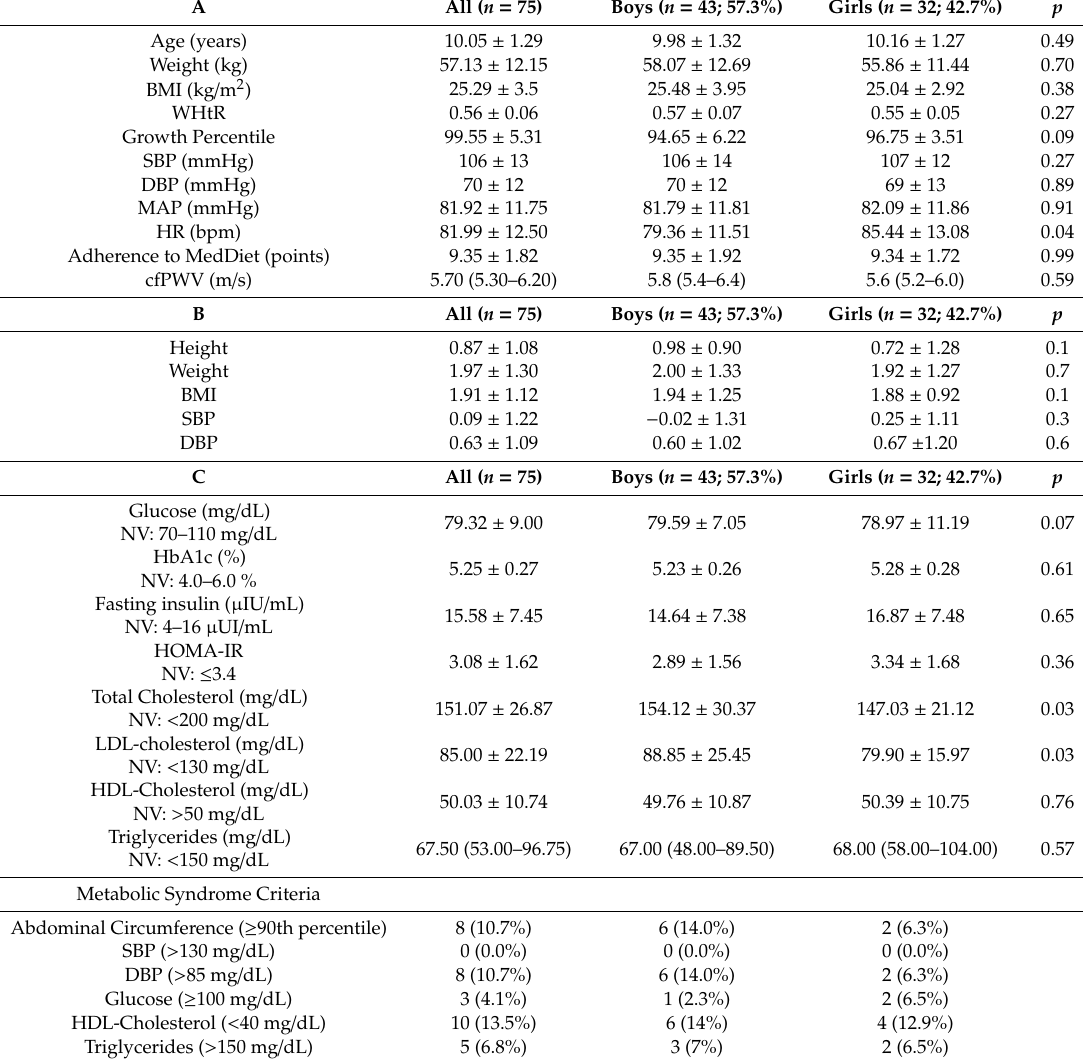
Table 1. Clinical parameters ( A ), SD (Z)-scores ( B ), and analytical ( C ) parameters and metabolic syndrome criteria, total and by sex (Mean ±